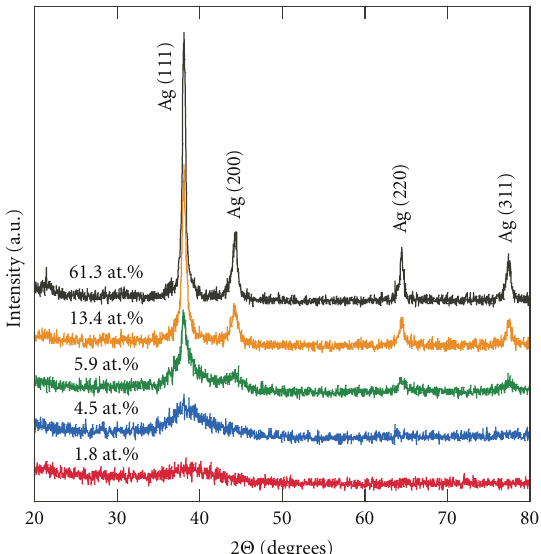
Figure 2: X-ray di ff ractograms of silver-containing DLC films with increasing amount of silver.